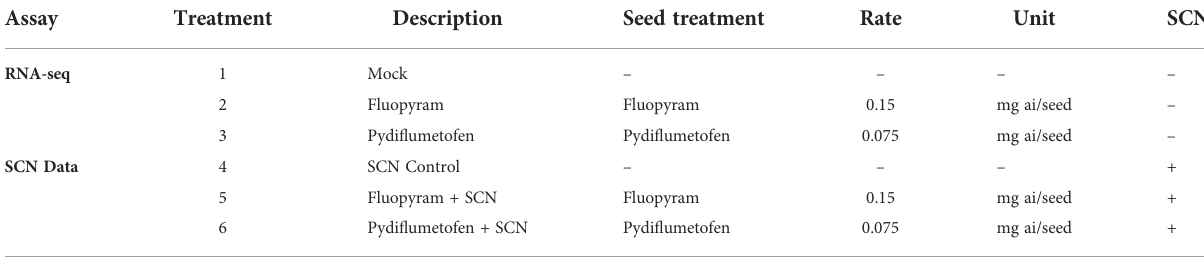
TABLE 1 List of treatments used for the greenhouse trials. Assay